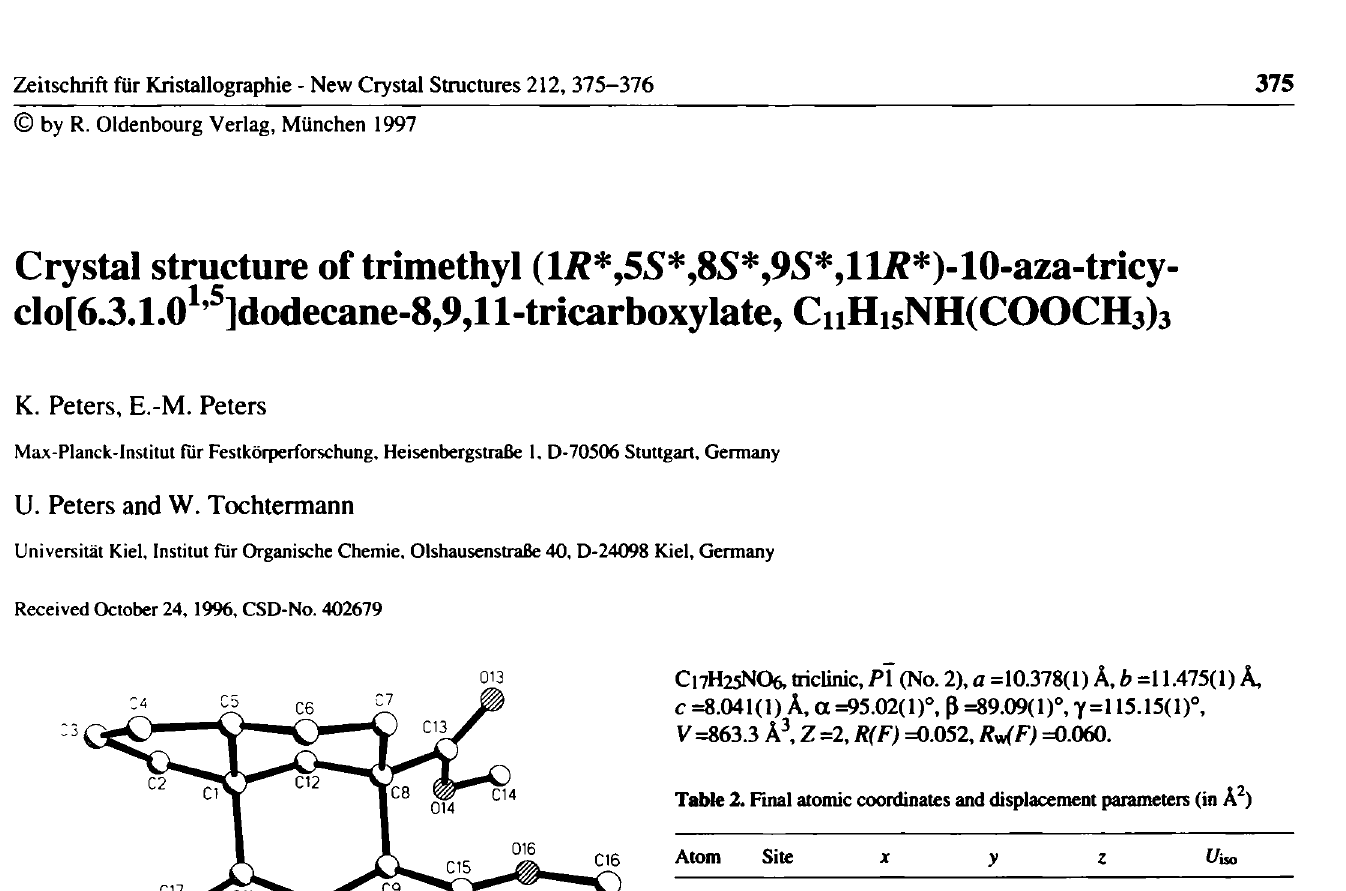
Table 2. Final atomic coordinates and displacement parameters (in A 2 )